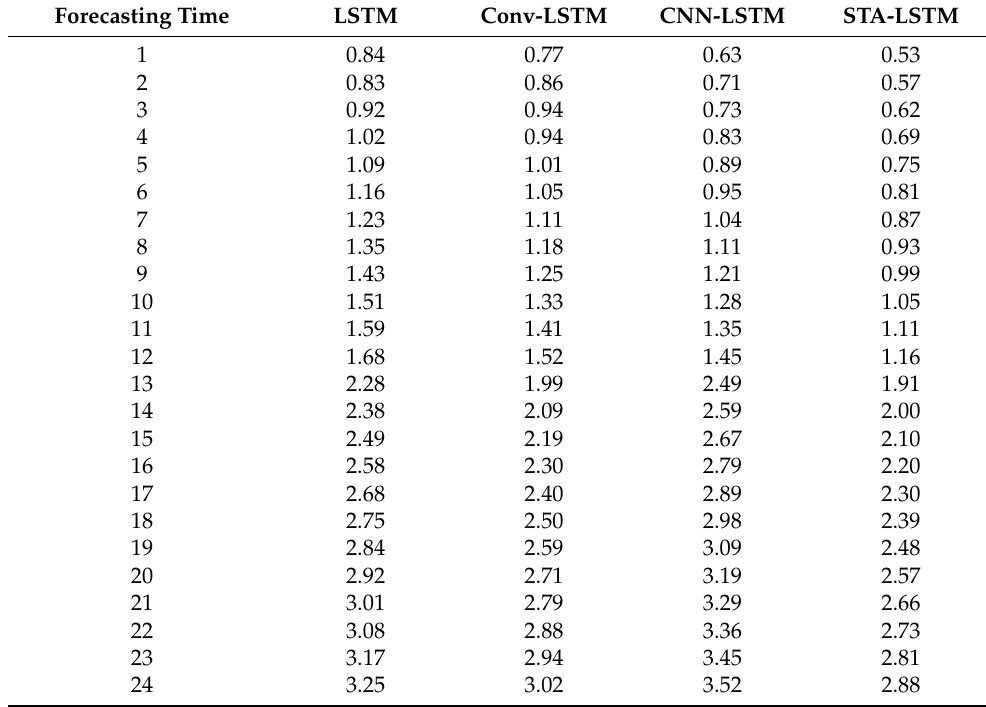
Table 2. Mean Absolute Error of the proposed models’